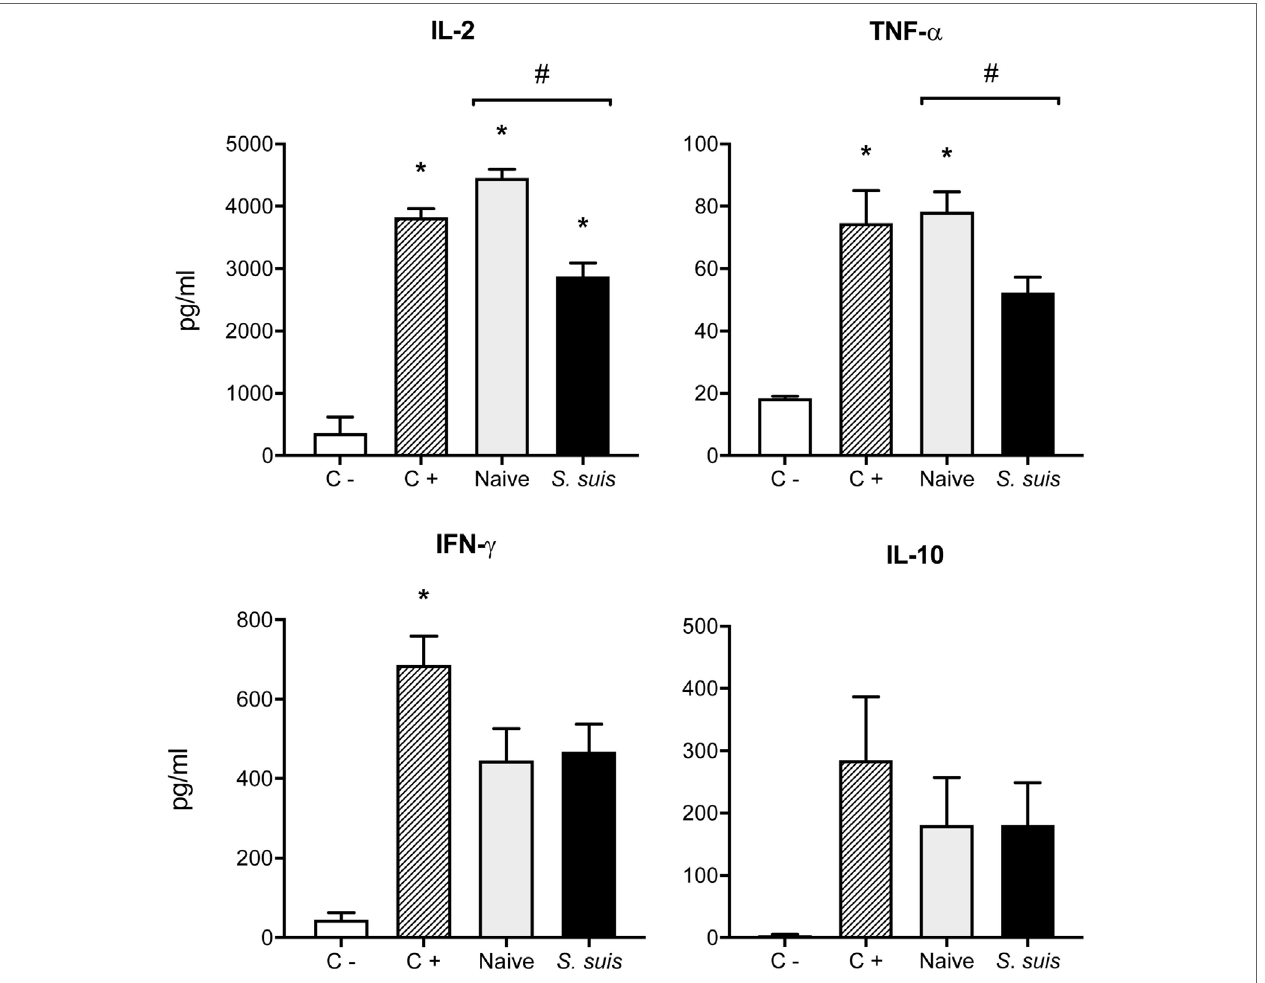
FigUre 8 | Splenic dendritic cells (DCs) from infected mice induce low Th1 cytokine production by CD4 + T cells. C57BL/6 mice were injected intraperitoneally with 5 × 10 7 CFU of Streptococcus suis wild-type (WT) strain P1/7. Spleens from mock-infected (naïve) and infected mice were harvested 6 h after infection ( n = 8 per group). Splenic DCs were purified by MACS positive selection and cocultured 24 h ex vivo with BO97.10 cells (DC:T cell ratio of 1:3) in Kappler–Marrack complete medium containing ovalbumin (OVA) (500 µg/ml) and antibiotics (100 µg/ml gentamycin). Supernatants were harvested and IL-2, TNF- α , IFN- γ , and IL-10 levels were quantified by ELISA. Cocultures incubated with medium alone served as negative controls (C − ), while cocultures treated with LPS (1 µg/ml) and OVA served as positive controls (C + ). Data are expressed as mean ± SEM (in pg/ml). *P < 0.05 indicates a statistically significant difference compared to unstimulated control cells. # P < 0.05 indicates a statistically significant difference between cells derived from naïve and infected